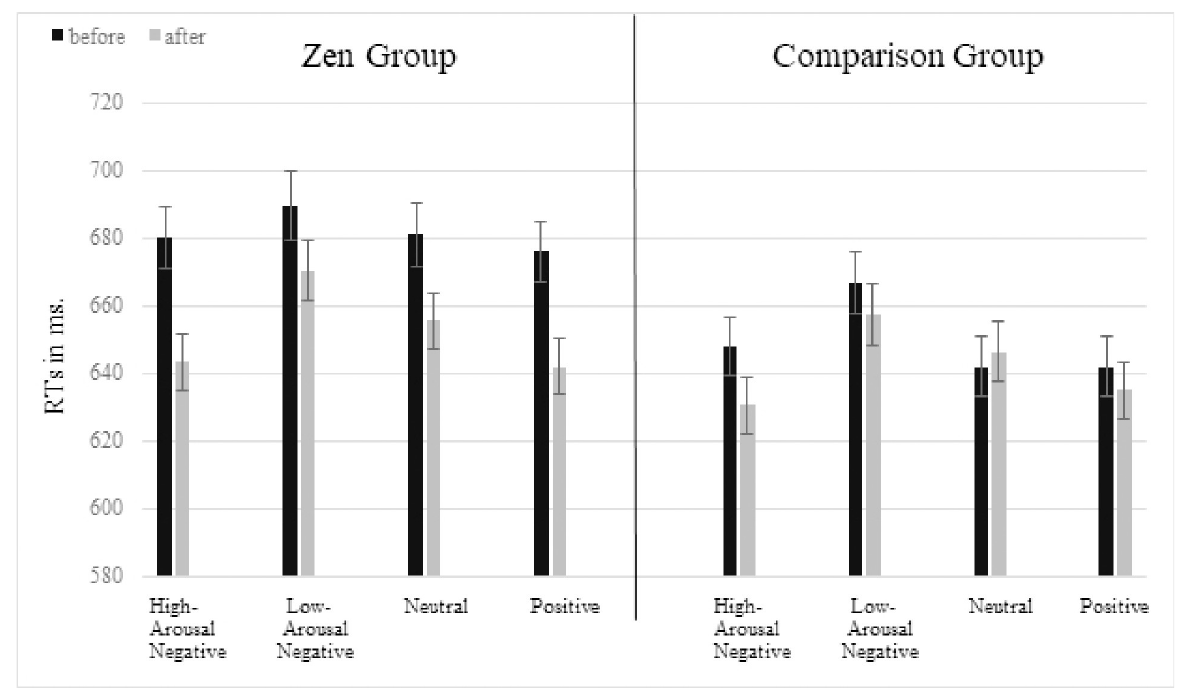
Fig 3. RTs in the lexical decision experiment. Error bars indicate standard errors.